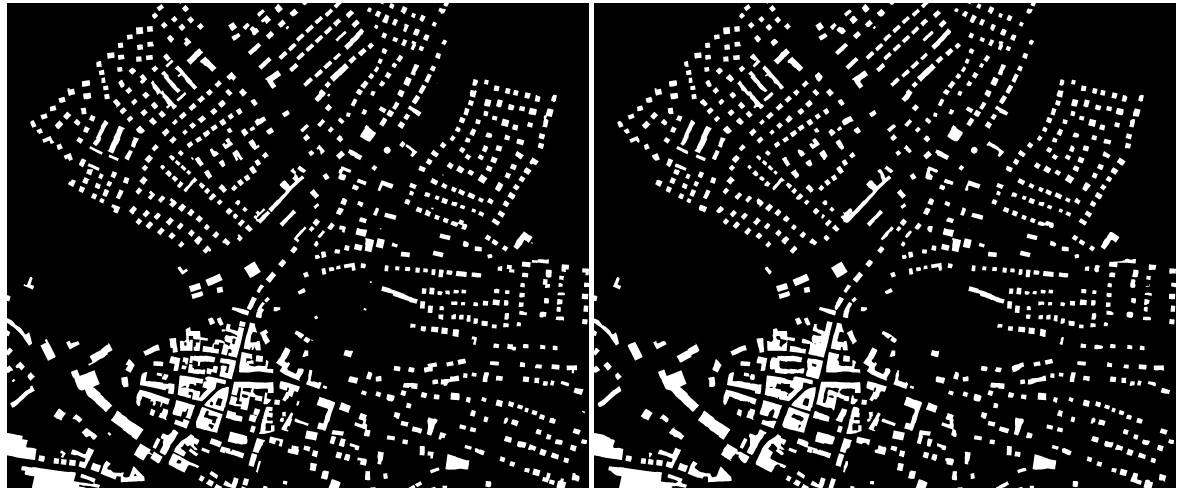
Figure 13. Scales 1:15.000 (left) and 1:25.000 (right) – residential and industrial buildings, inner